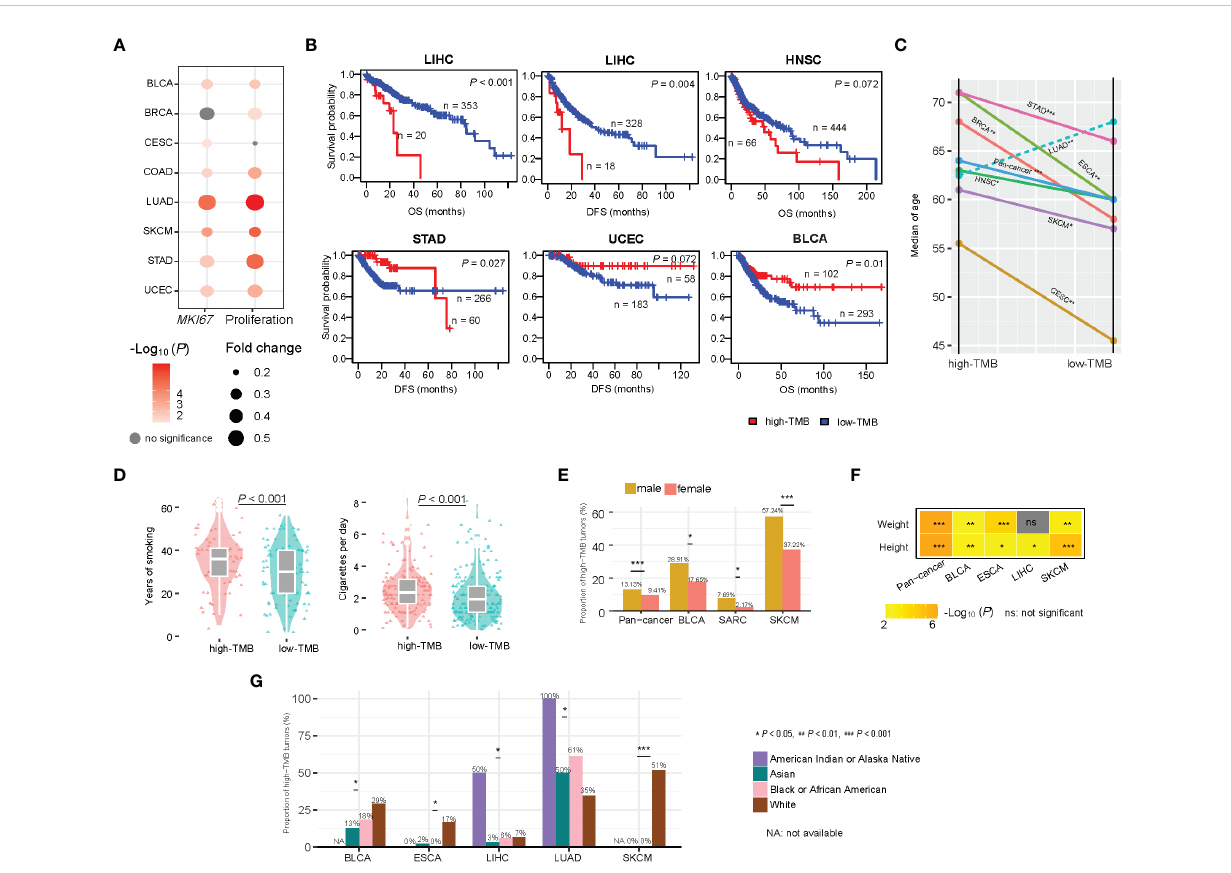
FIGURE 8 Associations between TMB and clinical features in cancer. (A) High-TMB cancers display signi fi cantly higher expression levels of MKI67 and proliferation signature scores than low-TMB cancers in diverse cancers. (B) Kaplan-Meier curves show that the association between TMB and survival prognosis is cancer type dependent. Associations between TMB and age (C) , smoking (D) , gender (E) , weight and height (F) , and race (G) in